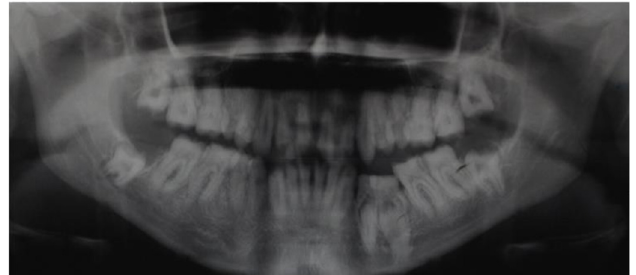
Fig. 2. Orthopantomogram showing thin enamel especially at the cemento-enamel junction and follicular enlargement being prominent in mandibular third molars.